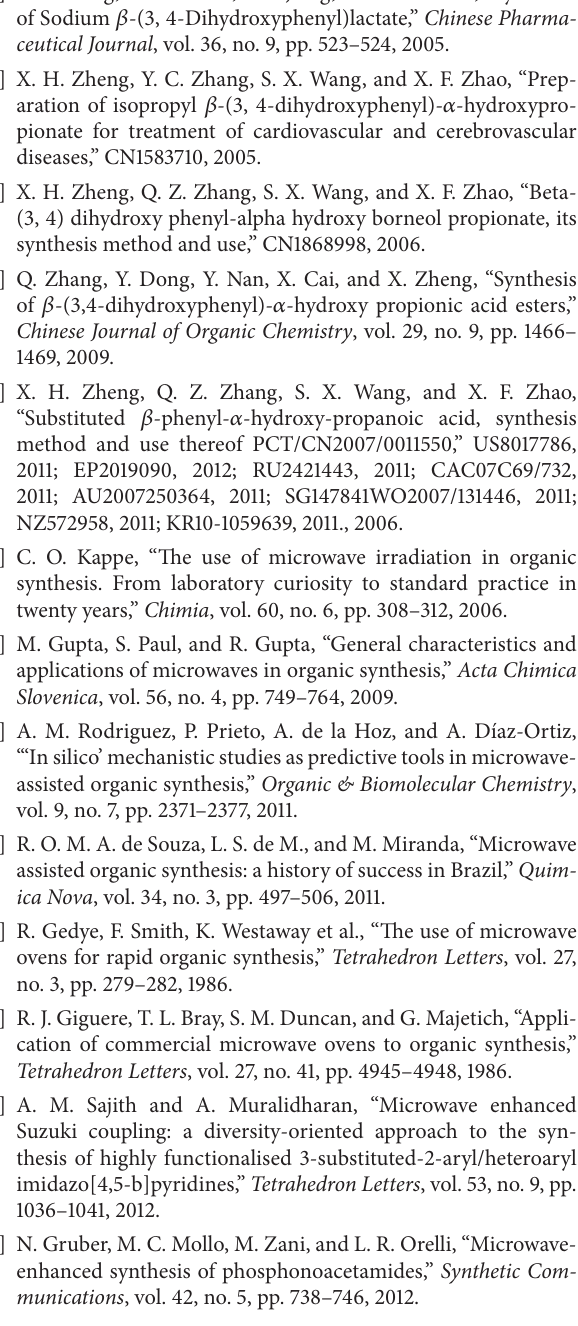
Table 10: Comparison of reaction results using microwave and conventional heating methods. Product Azolactone Acrylic